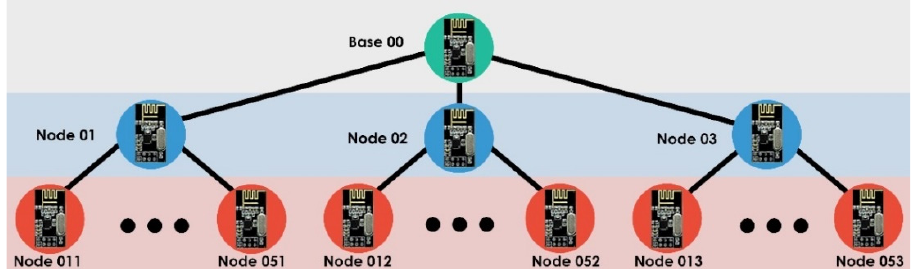
Figure 11. Tree topology diagram .